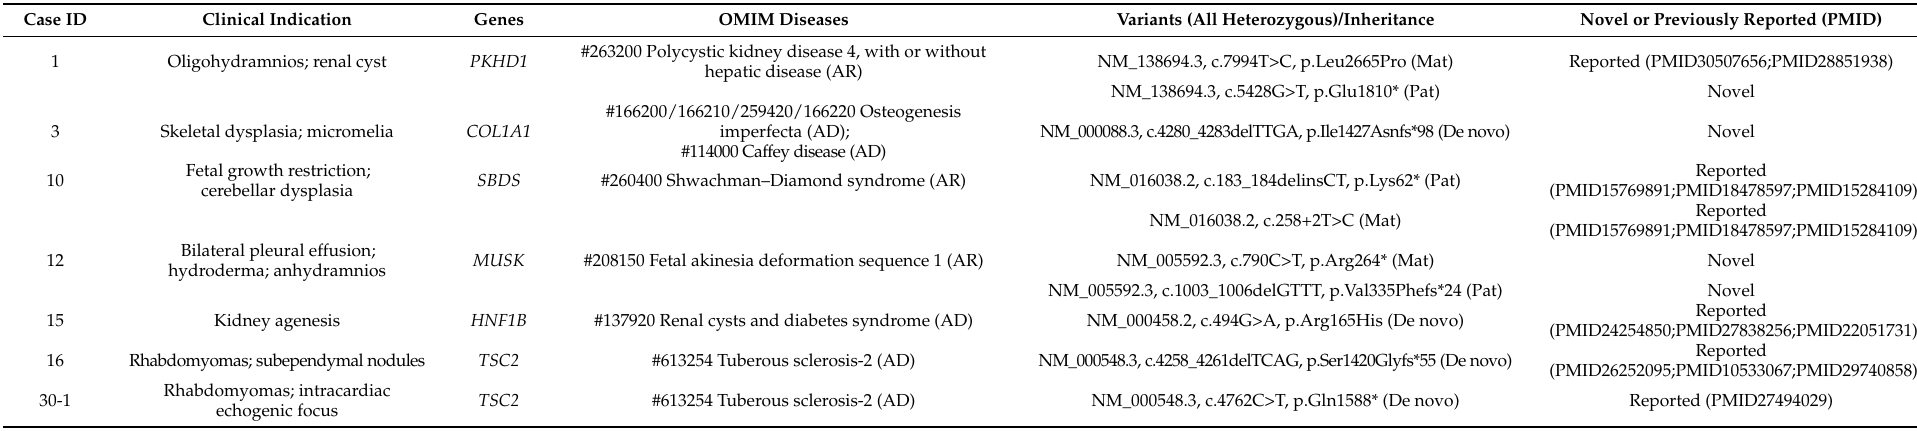
Table 2. Summary of pathogenic or likely pathogenic single nucleotide variants (SNVs) and small insertions or deletions (INDELs) detected by WES and